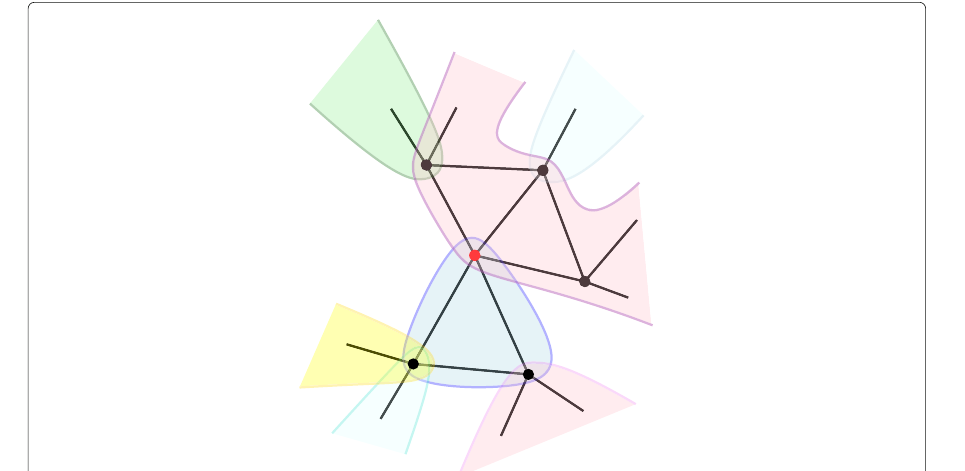
figure sheds light on the local structure of the model: note that the red vertex is part of two communities, which consequently overlap with each other. Through these communities, we reach the neighbors of the red vertex. Through the neighbors, we may again enter new communities, and so